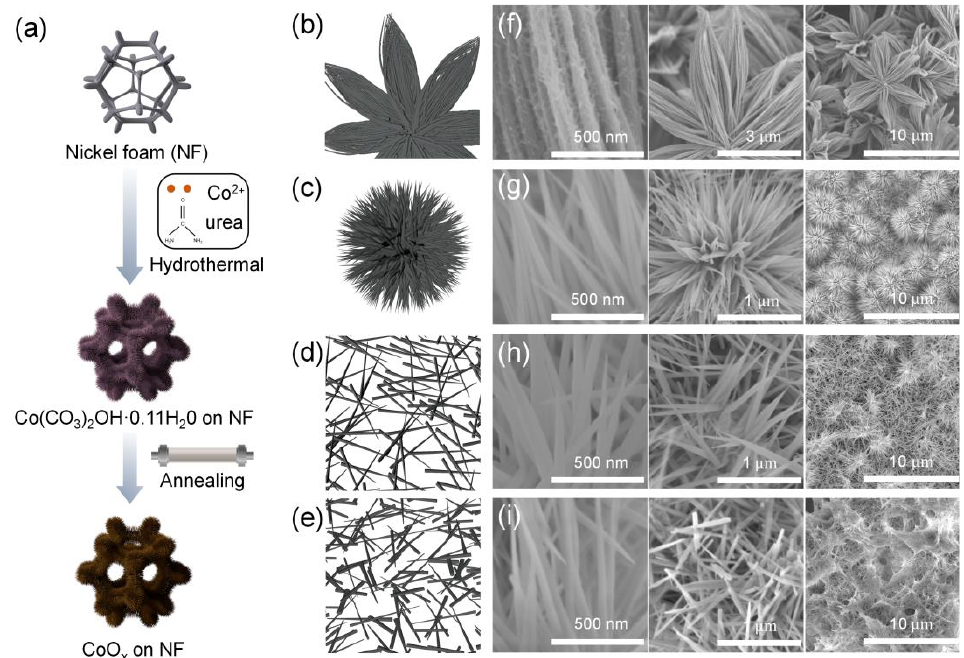
Figure 1. ( a ) Schematic illustration of the fabrication process of the self-supported CoO x ; schematic diagrams of the ( b ) CoO x -110, ( c ) CoO x -120, ( d ) CoO x -130, and ( e ) CoO x -140; FE-SEM images of the ( f ) CoO x -110, ( g ) CoO x -120, ( h ) CoO x -130, and ( i ) CoO x -140.